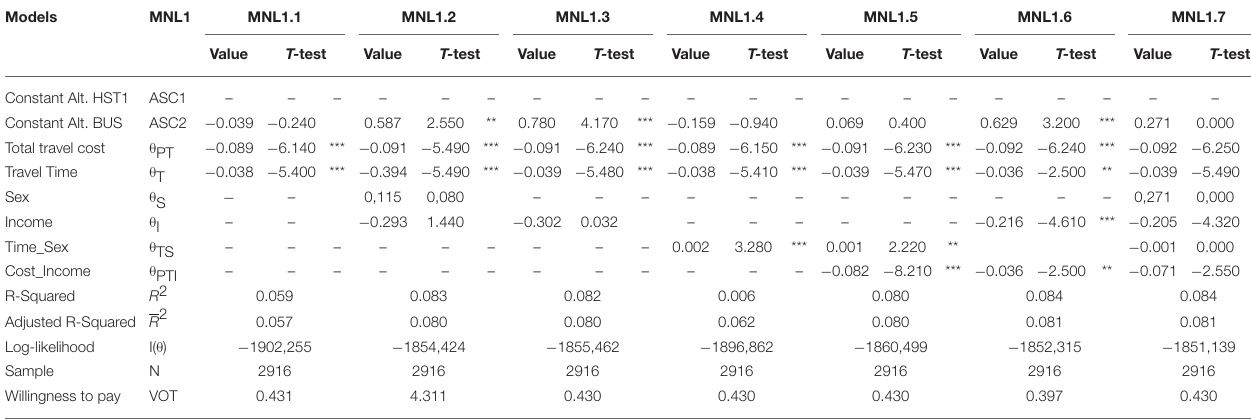
TABLE 1 | Estimated logit binomial model results MNL1 (HST1-BUS). Models